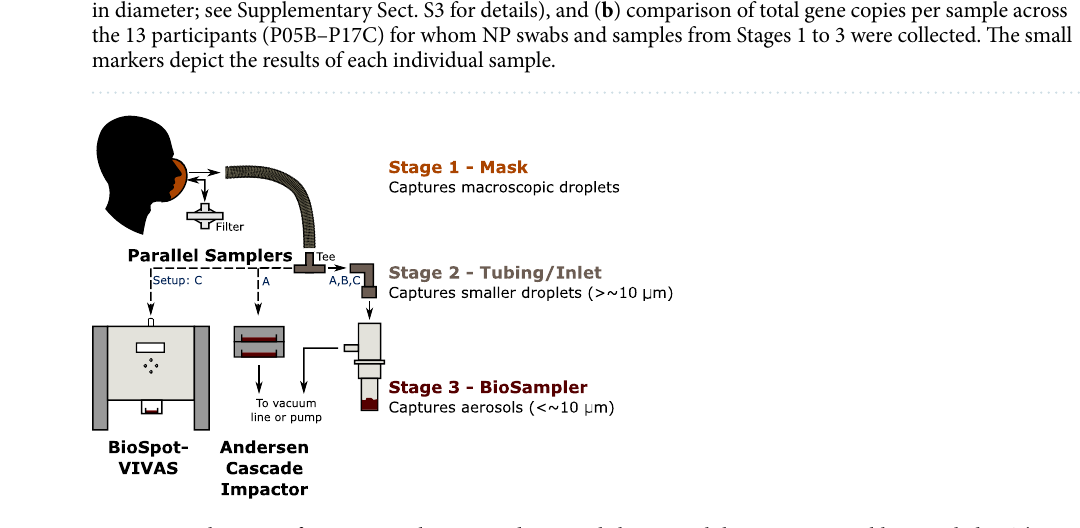
Figure 3. Schematic of experimental setup used to sample bioaerosol that was presumably virus-laden. The evolution of the setup over the duration of the project is summarized in Table